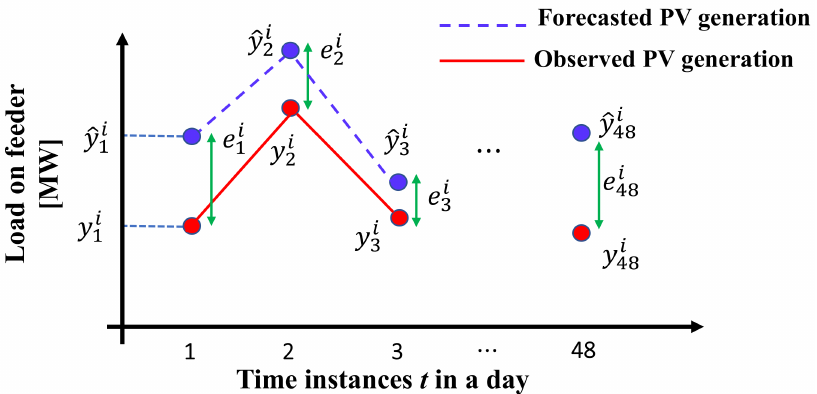
Figure 5. Forecasted and observed PV generation on the i -th